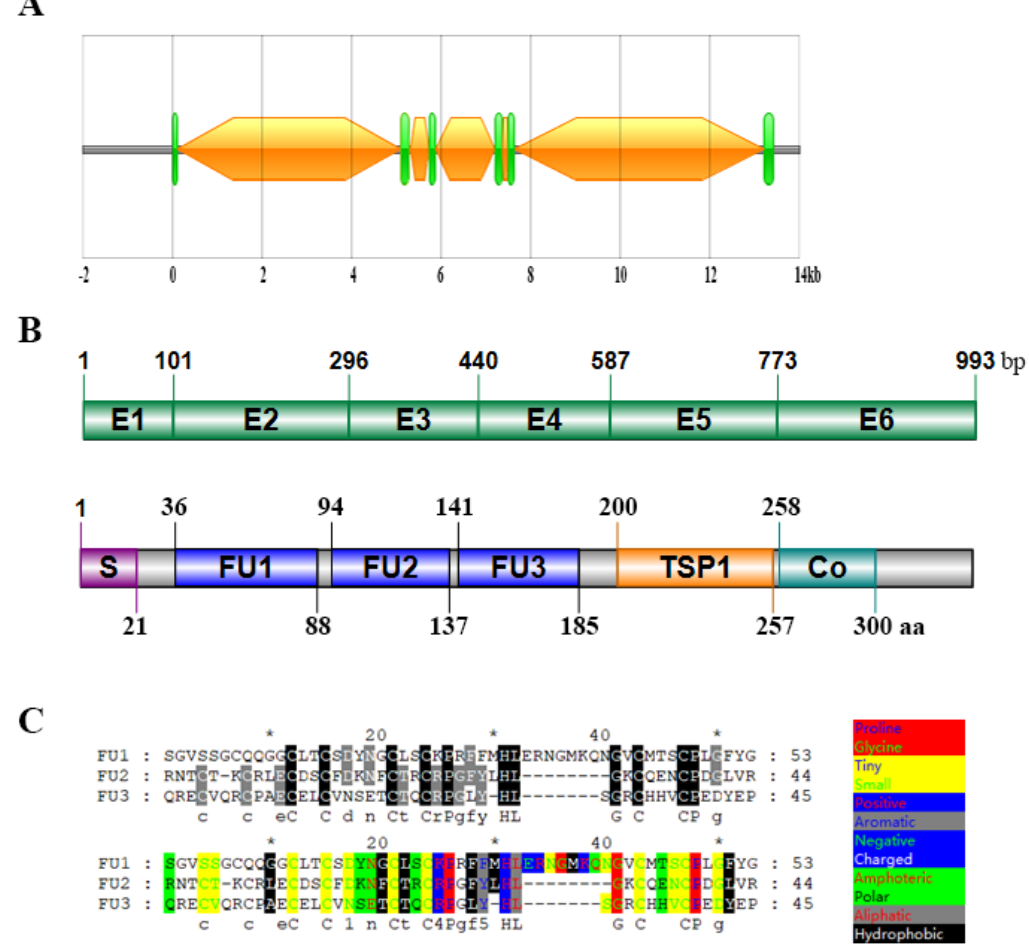
Figure 1. Sequence and structure of Cynoglossus semilaevis Rspo3 /RSPO3. ( A ) Gene structure of Rspo3 . Exons are shown in green quadrangles, whereas introns are shown in orange hexagons; ( B ) Above: exon composition of C. semilaevis Rspo3 coding sequences (CDS). Below: conserved domains of C. semilaevis RSPO3. E: exon; S: leading signal peptide; FU: cysteine-rich furin-like domain; TSP1: thrombospondin-type1 domain; Co: coiled coil region; ( C ) Sequence and physicochemical analysis of three FU domains. Above: amino acids that are conserved in the three domains are shown in black, whereas those that are conserved in two domains are shown in grey. Below: different physicochemical properties are marked in different colors.